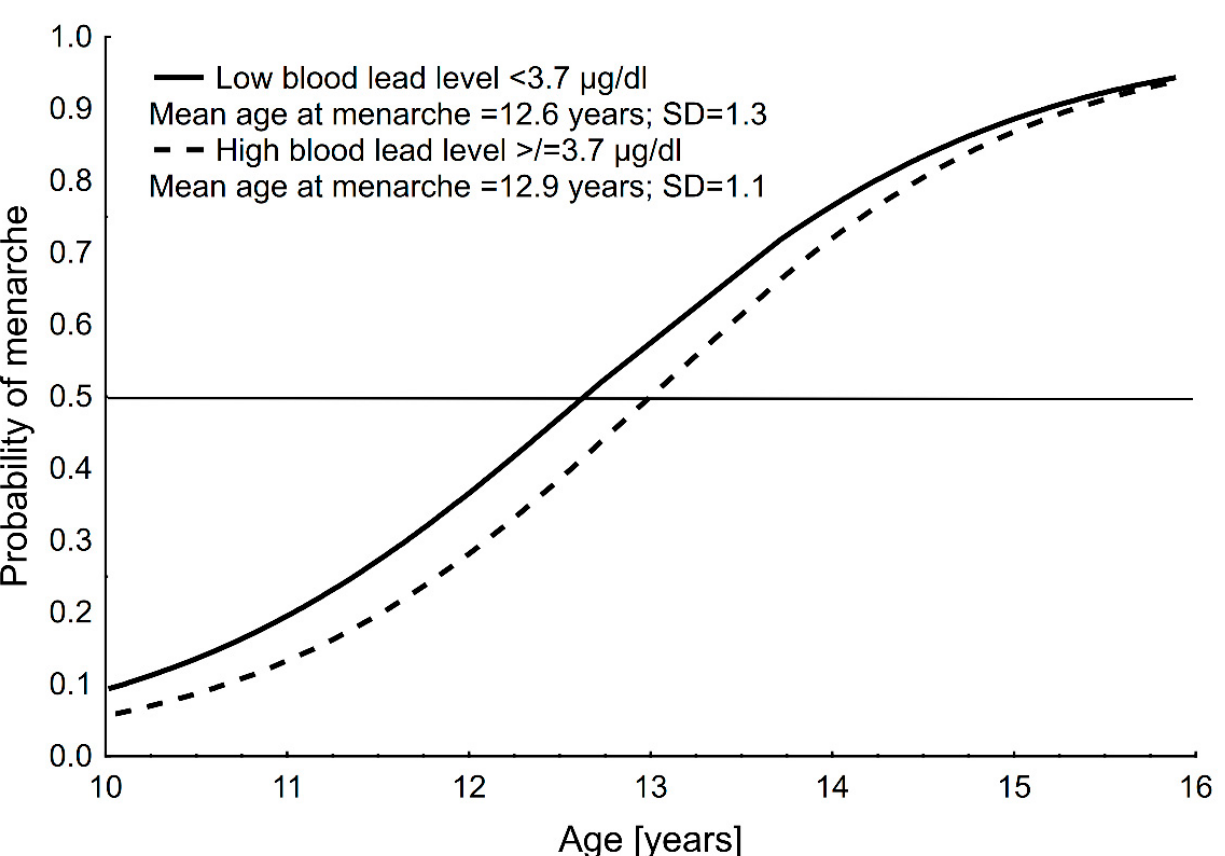
Figure 1. Distribution of the probability of menarche with age in the two blood lead level groups of girls in Polkowice in 2008. Age at menarche was assessed using the status quo method and calculated with probit analysis.